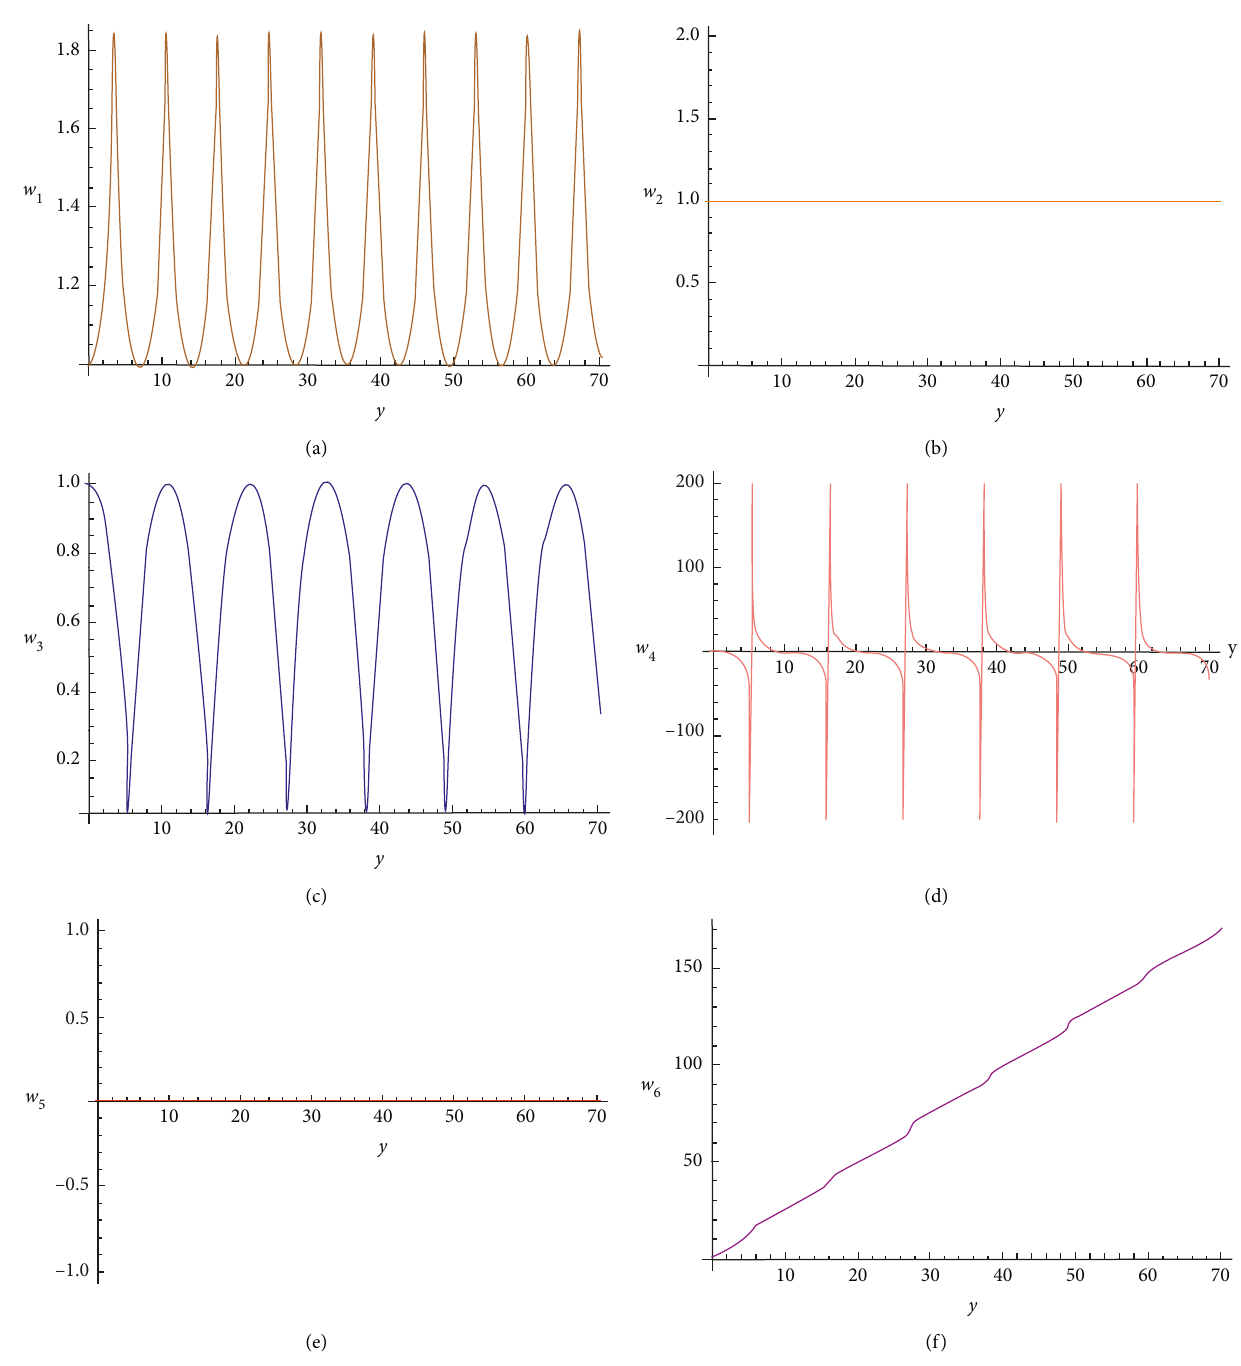
Figure 4: 2D analysis of CVs w